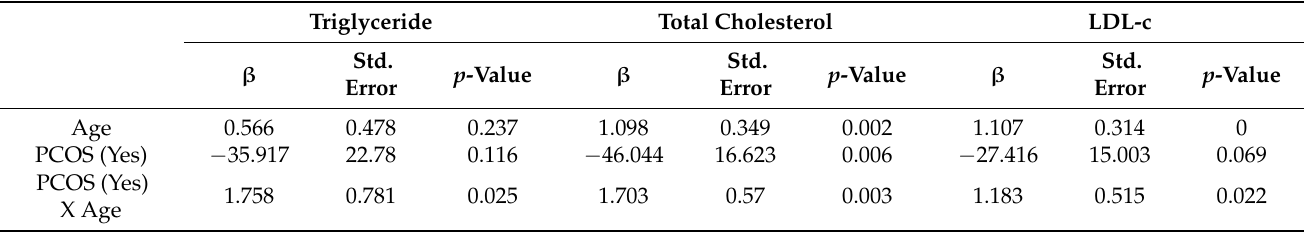
Table A1. Interaction effects of age and PCOS condition on lipid